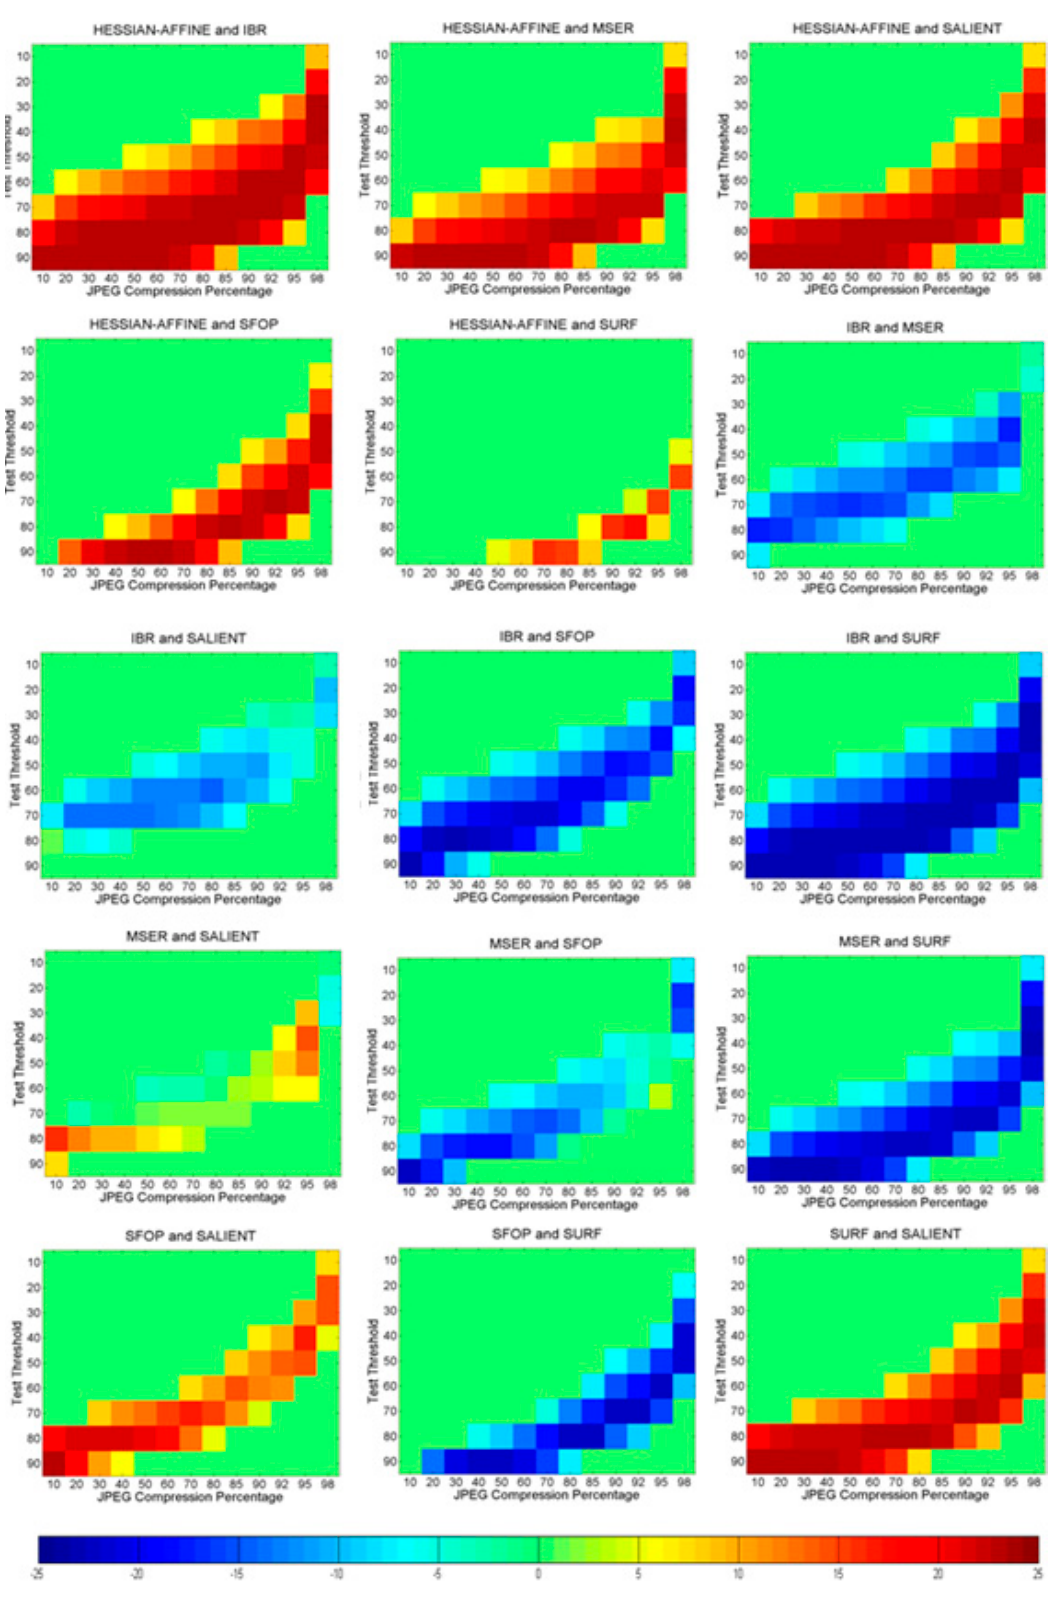
Figure 11. JPEG compression results for Hessian-Affine, IBR, MSER, SFOP and SURF with other detectors showing Z -scores; positive Z -scores show that the first detector is better than the second whereas negative values show the converse.